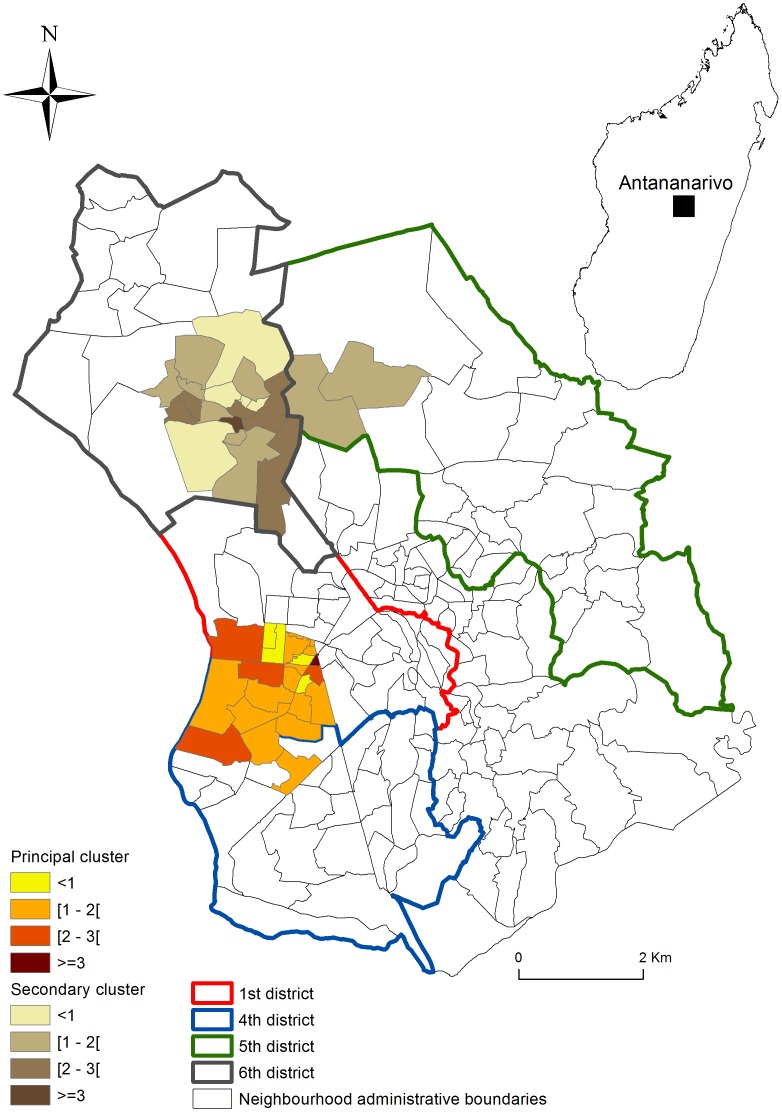
Relative risk of TB incidence, principal cluster was found in the 1st and 4th districts, secondary cluster was found in 5th and 6th districts.